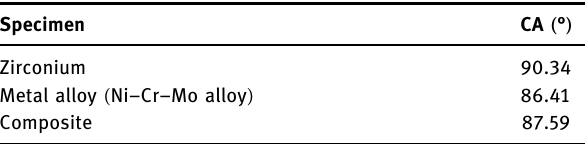
Table 2: CA of zirconium, metal alloy and composite Specimen